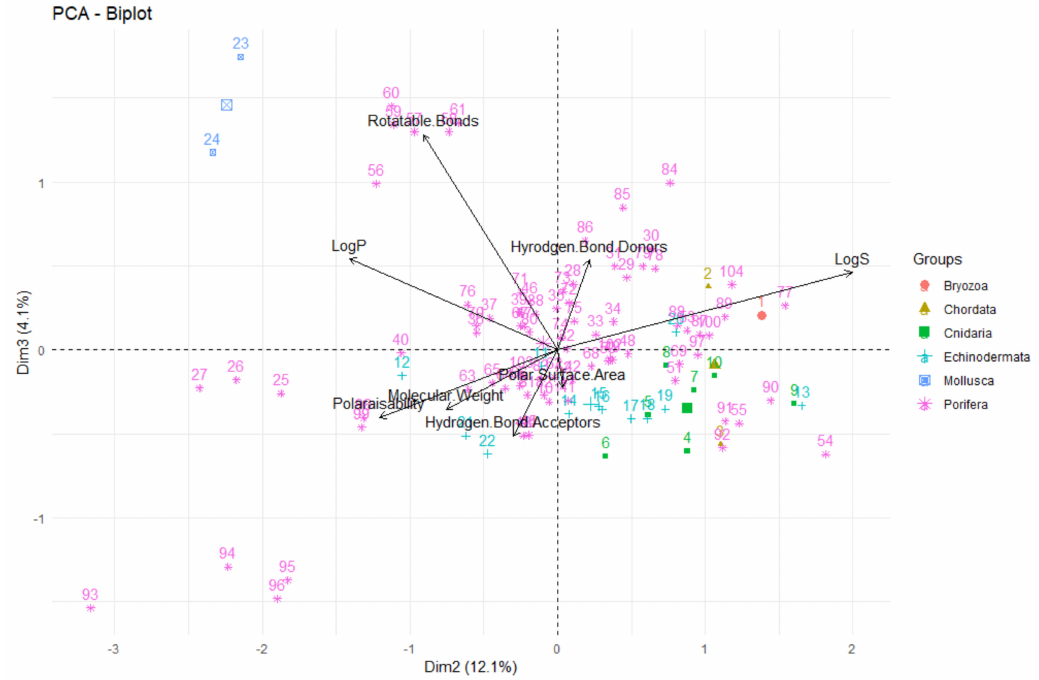
Figure 19. Biplot representing the PCA analysis on the compounds isolated from organisms in the Animalia Kingdom and their molecular descriptors (PC2 vs. PC3). The arrows represent molecular descriptors and the direction in which they hold influence. Each point represents a